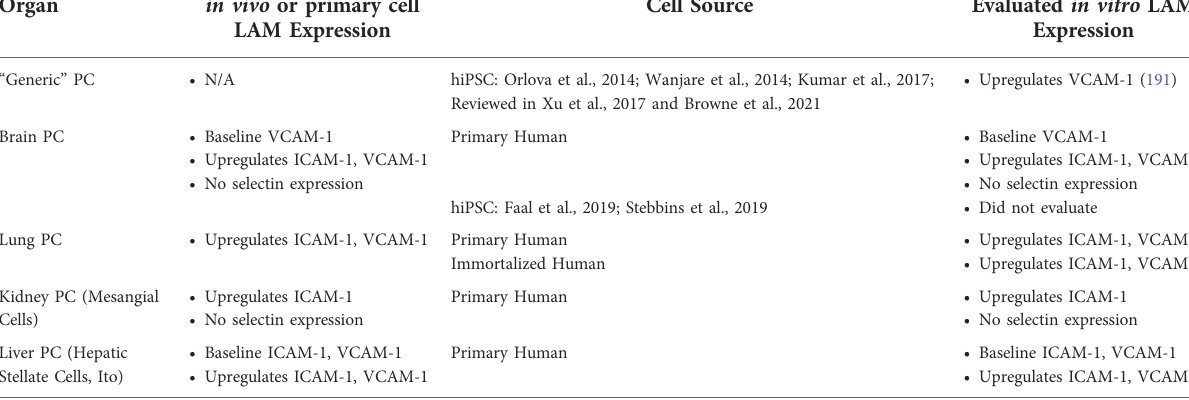
TABLE 3 Pericyte sources for tissue